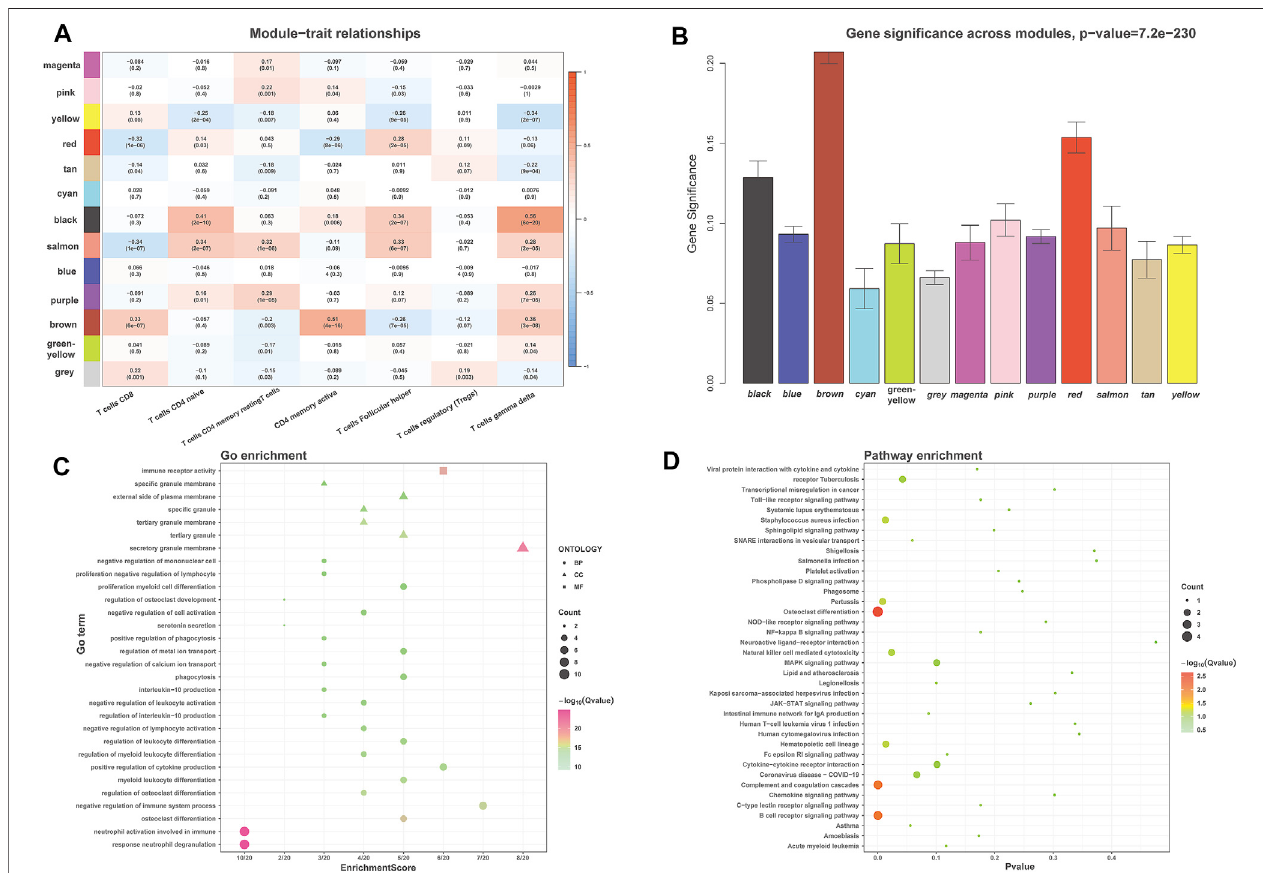
FIGURE 4| WGCNA identi fi ed the signi fi cant module about activated memory CD4 + T cells in fi ltration. (A) Heatmap showed the correlation of module eigengenes with T cells in fi ltration. The row represented the module, and the column portrayed the character. The values in the box represented correlation and p -value. (B) The histogram showed the relationship between different gene modules and gene signi fi cance, and the brown module showed the highest signi fi cance. (C,D) GO (C) and KEGG (D) analysis for brown module-related genes. GO, Gene Ontology; KEGG, Kyoto Encyclopedia of Genes and Genomes.